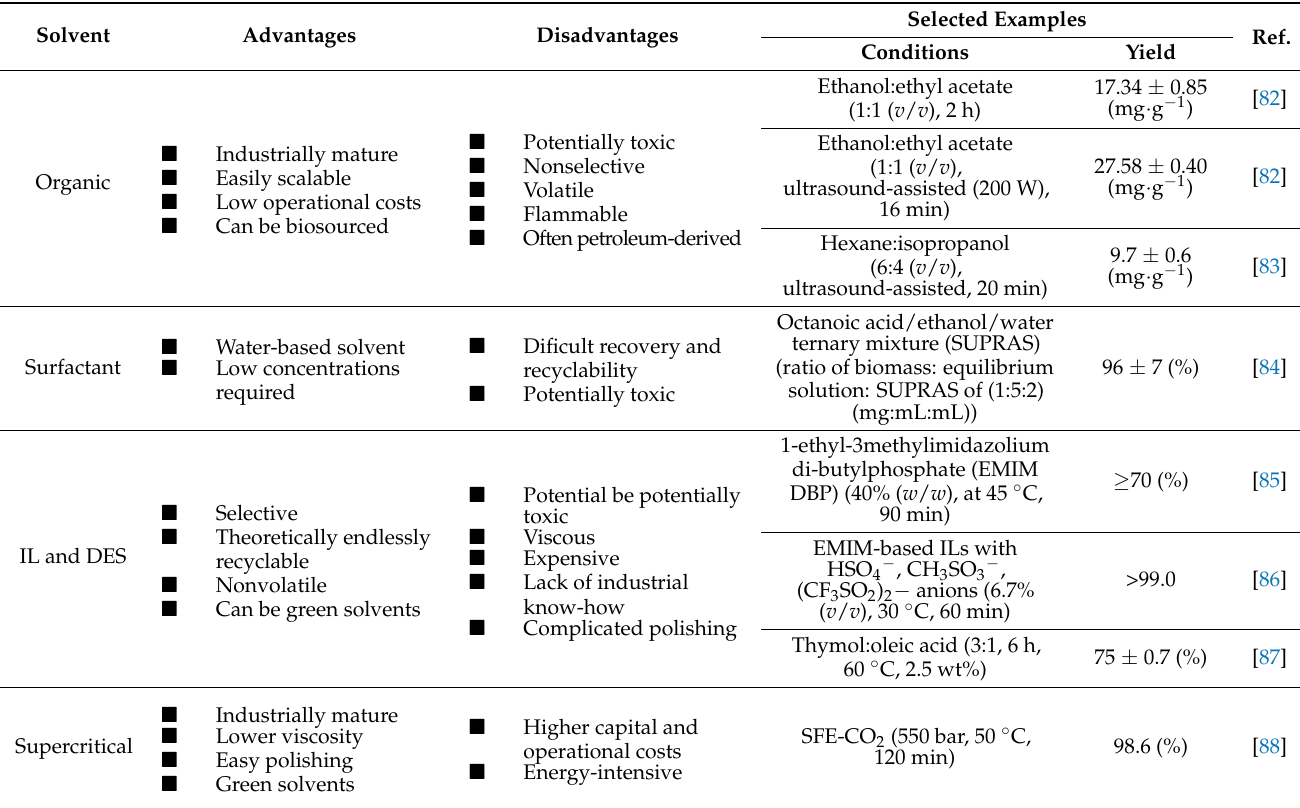
Table 3. Main advantages and disadvantages of several faction methods and comparison of the methods of extraction of astaxanthin from Haematococcus pluvialis . Advantages Disadvantages